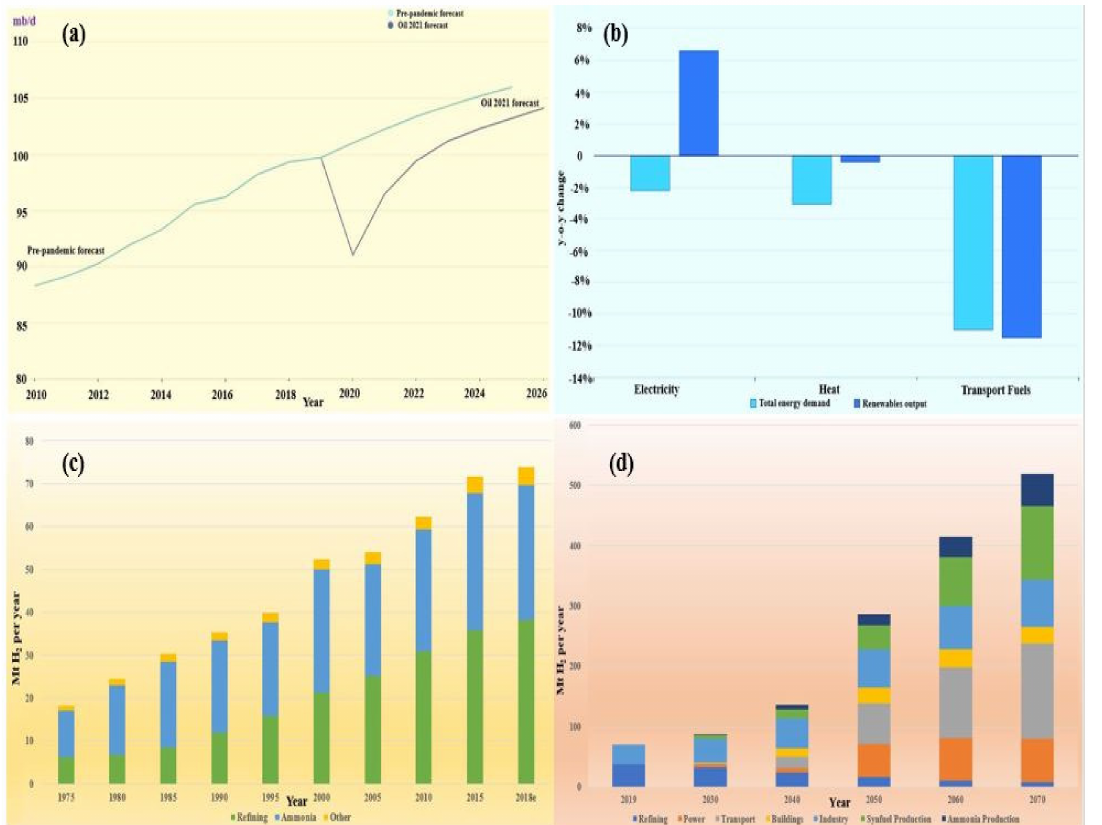
Figure 1. ( a ) Oil demand forecast, 2010–2026, pre-pandemic and in Oil 2021 [6]. ( b ) Change in energy demand and renewables output in electricity, heat and transport, 2019 to 2020 [13]. ( c ) Global demand for pure hydrogen, 1975–2018 [36]. ( d ) Global hydrogen demand by sector in the Sustainable Development Scenario, 2019–2070